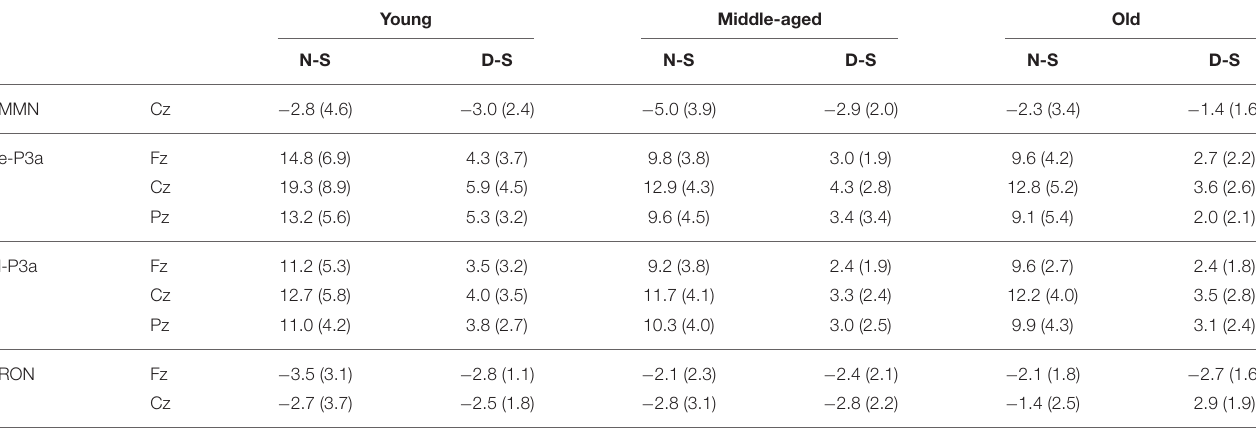
TABLE 1 | Mean values and standard deviations (in brackets) of amplitudes ( µ V) for MMN (100–250ms), e-P3a (280–400ms), l-P3a (350–500ms), and RON (400–700ms) components, in the novel minus standard (N-S) and deviant minus standard (D-S) difference waveforms, for the three age groups (Young, Middle-aged, Old).